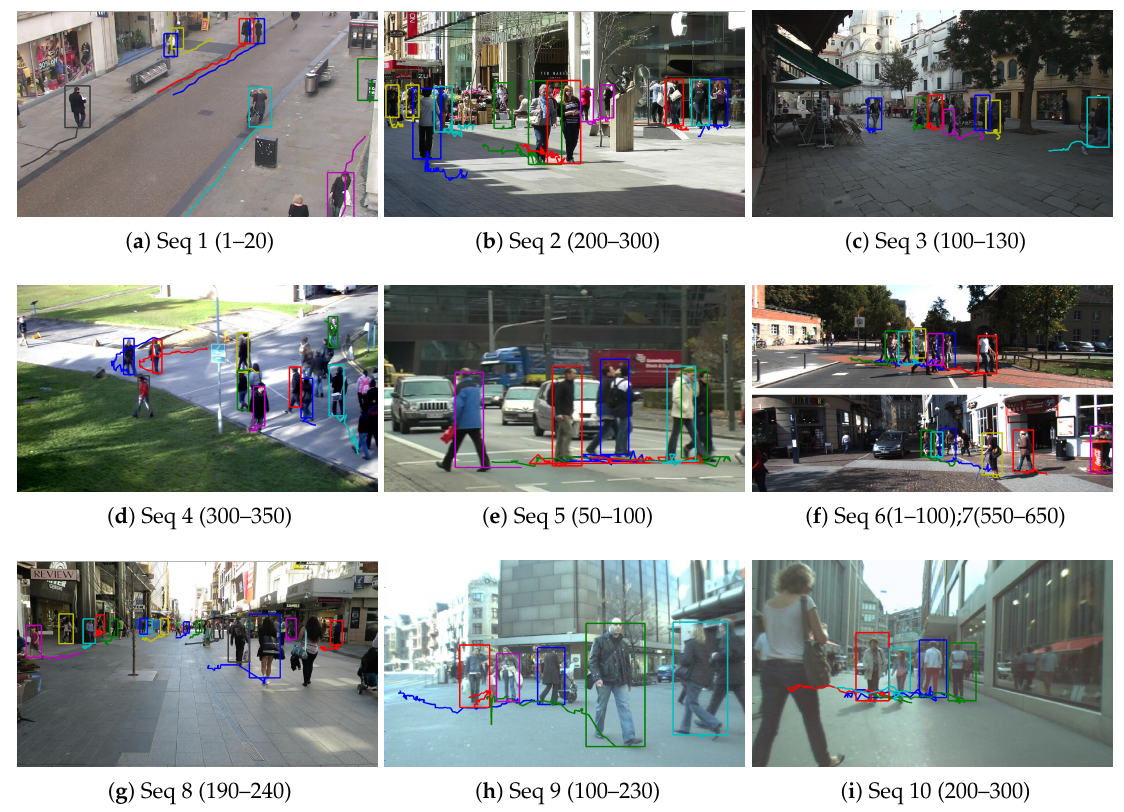
Figure 6. Tracking results on the 2D MOT 2015 dataset. There are ten sequences in the figure, in which ( f ) contains two sequences. The ETH-Crossing sequence is not shown because it has less targets. The former six sequences ( a – e ) and the upper one in ( f ) are static camera cases; the rest are motion camera